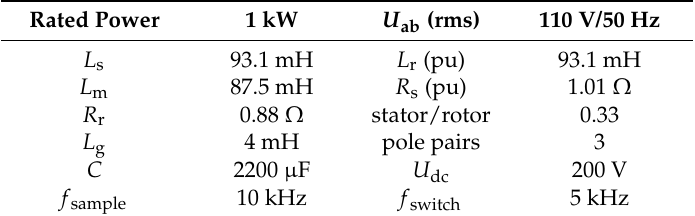
Table 3. Parameters of The Tested System.